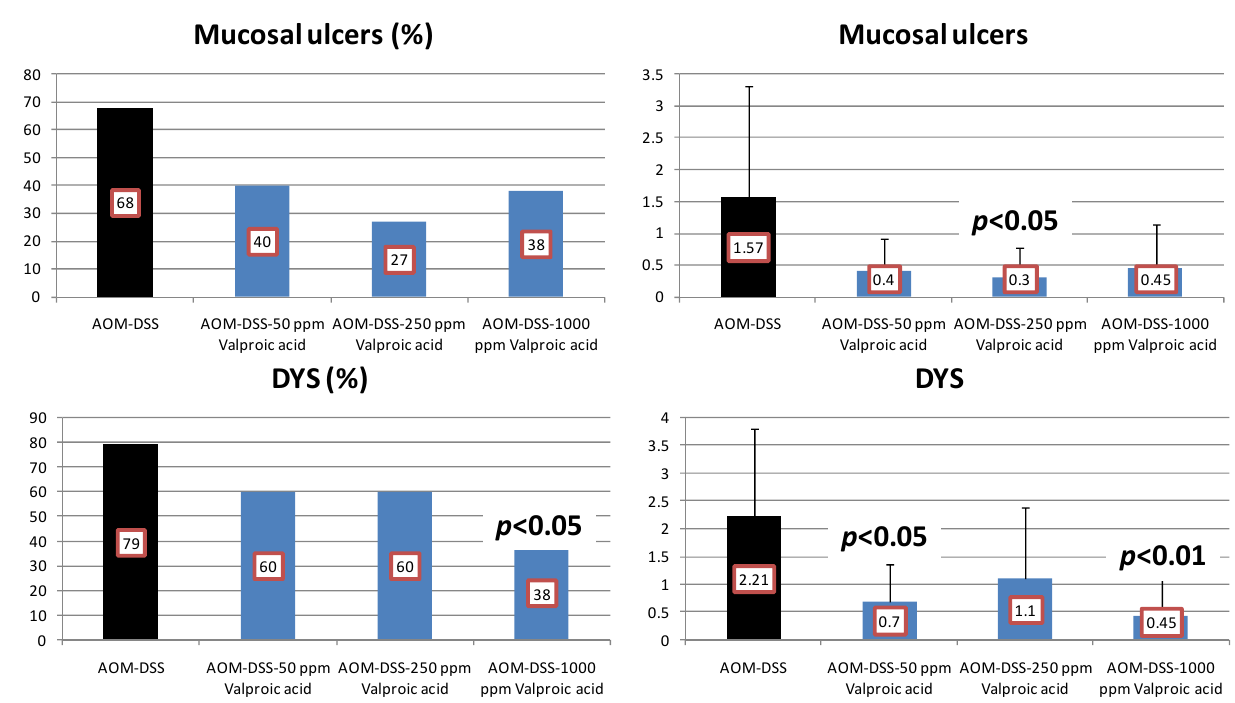
Figure 7. Incidences and multiplicities of mucosal ulcer and dysplastic crypts in the Valproic Acid (VPA)